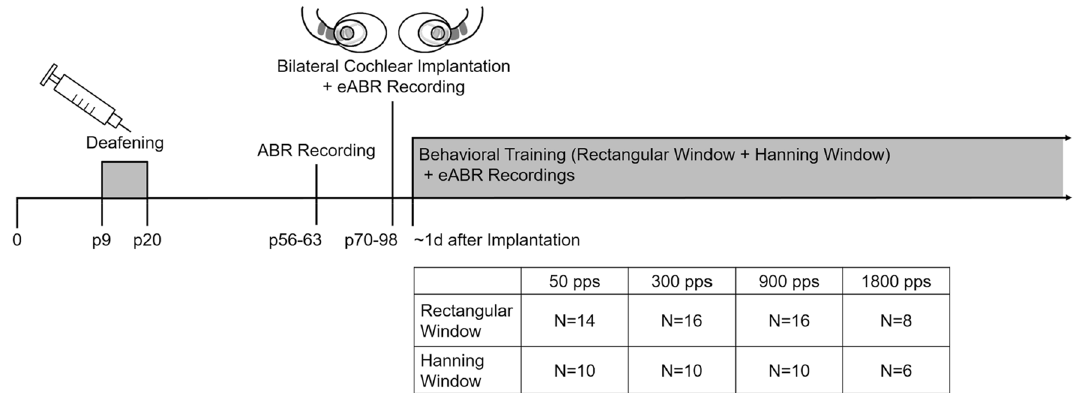
Figure 1. Experimental pipeline with timeline and number of animals (N) tested per condition. Abbreviations: ABR acoustically evoked auditory brainstem response, eABR electrically evoked auditory brainstem response, p postnatal day, pps pulses per second, d